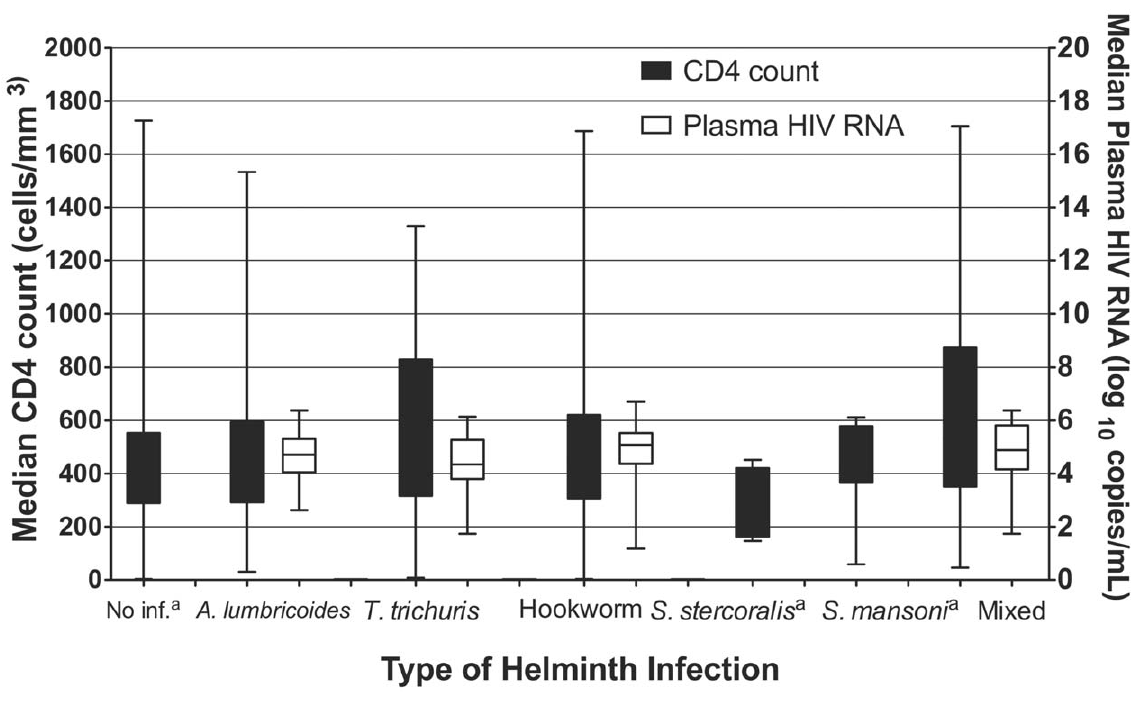
Figure 3. Median CD4 count and plasma HIV RNA level by helminth species. a No HIV RNA data were available for S. stercoralis or S. mansoni . The study aimed to recruit pre-HAART individuals with CD4 counts greater than 250 cells. Participants were allowed to give CD4 count measurements from their prior HIV Care and Treatment Clinic visit if it fell within three months of the screening date. However, when these CD4 counts were confirmed, many people had lower CD4 counts than recorded by history. Eighty-nine participants had CD4 counts between 0–199 cells/ m L 3 and 256 participants had CD4 counts between 200–349 cells/ m L 3 .